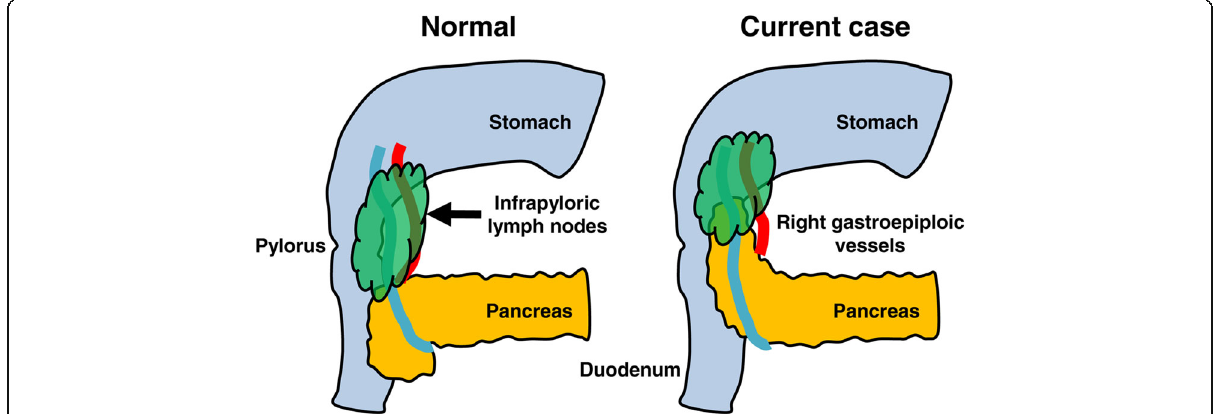
Fig. 4 Schema of the infrapyloric lymph node area. The left-side schema represents normal anatomy, while the right-side schema represents intestinal